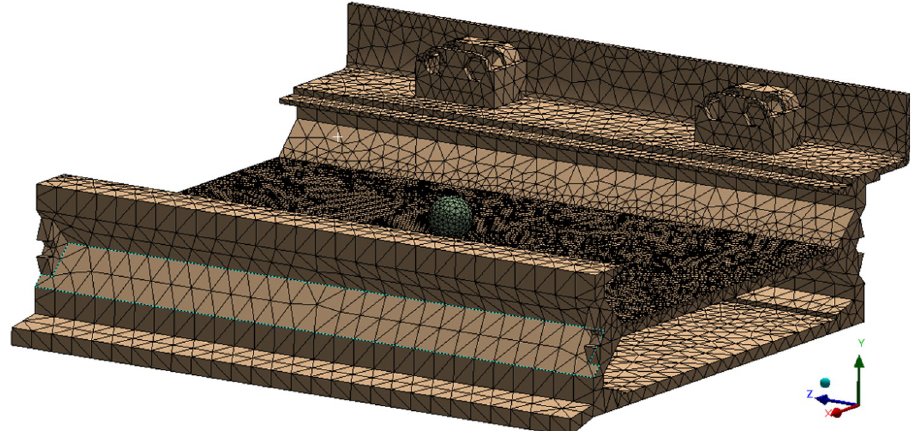
Fig 3. Grid model of a single section of the middle trough.